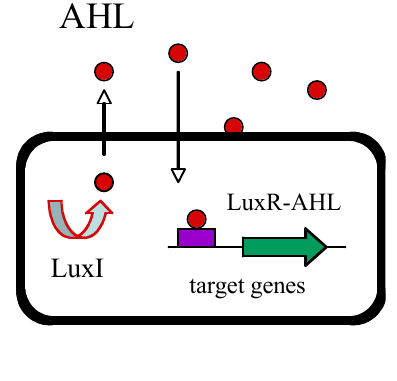
Transcriptionranscription is activatedis activated at at high cell density